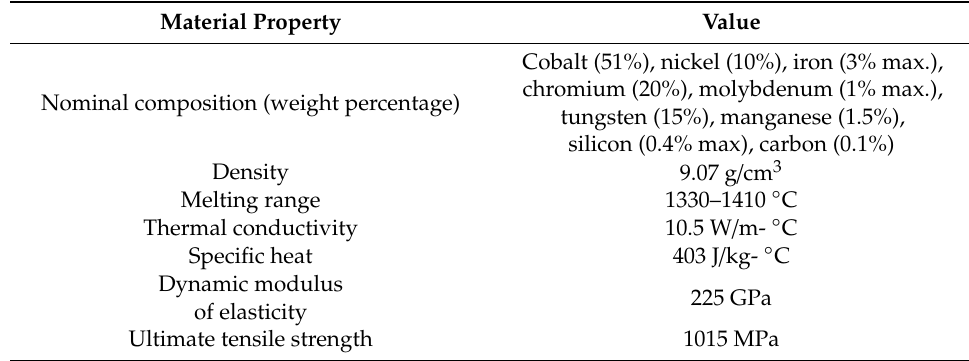
Table 1. Specifications of Haynes 25 material at room